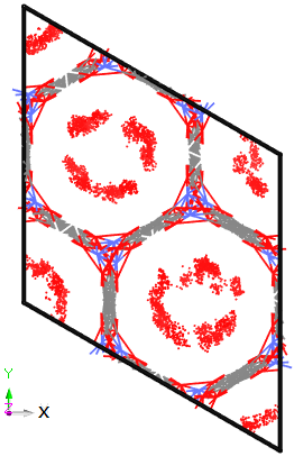
Figure 3. Adsorption sites of R1234ze in Co-MOF-74 at 353 K and 5 MPa.